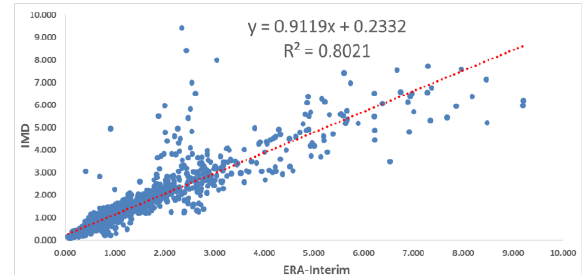
Figure 18. Scatter plot between daily rainfall in ON season of Era-Interim and APHRODITE rainfall products 4.3 Region Specific Suitability of Era-Interim